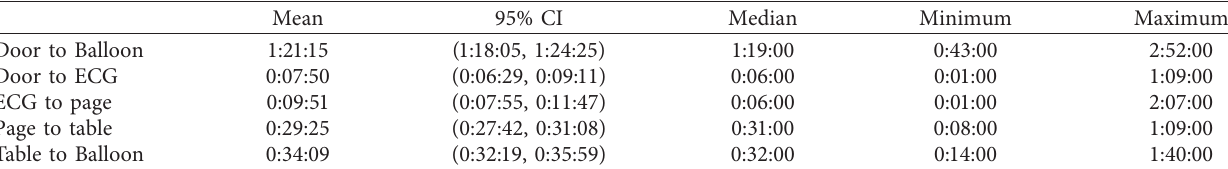
Table 3: Overall population metrics for door to balloon